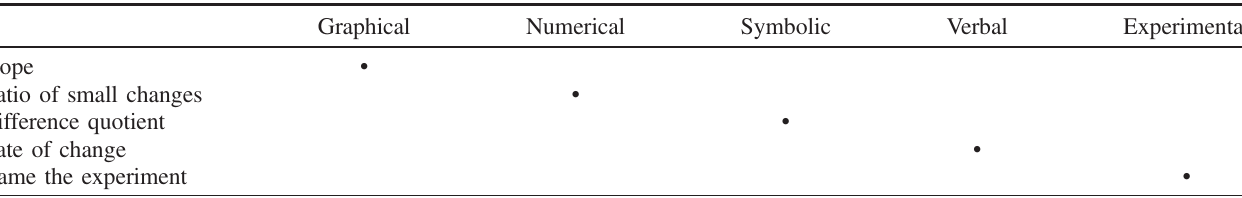
TABLE I. Representations of derivatives. Each column describes one form of representation, extending the Rule of Four [28] to include an experimental representation. Each row corresponds to a separate way of understanding the concept of derivative. Graphical Numerical Symbolic Verbal Experimental Slope Ratio of small